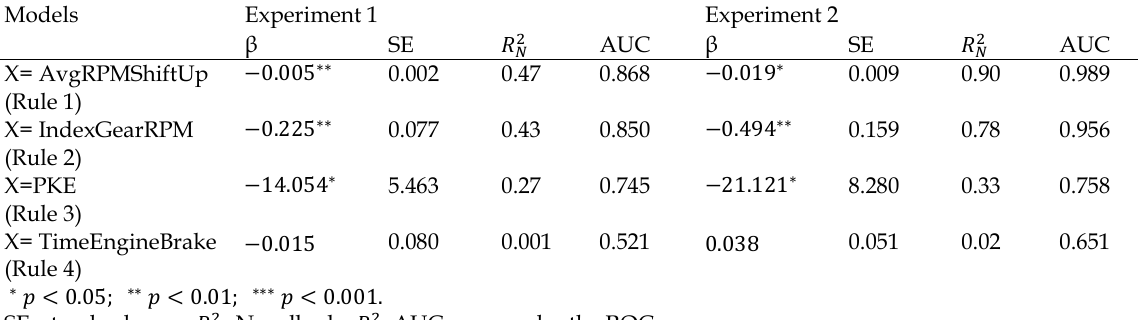
Table 7. Logistic regression models for 90km/h speed